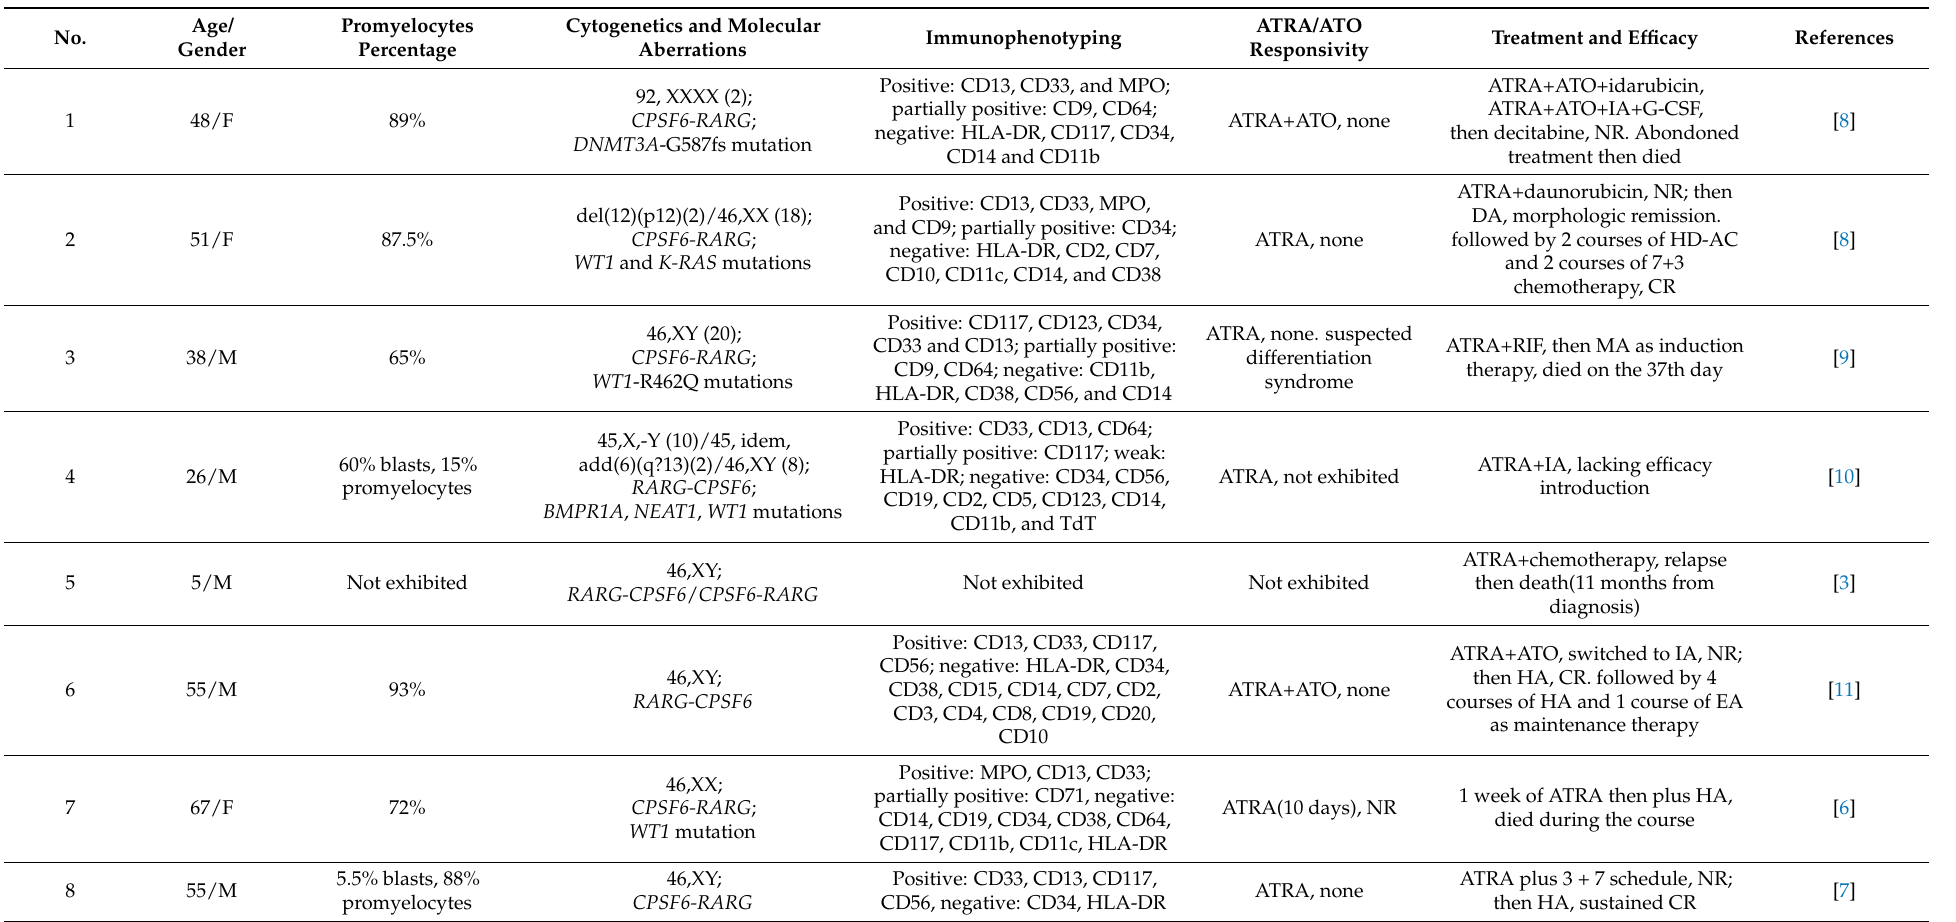
Table 1. Cases of APLL harboring CPSF6-RARG or